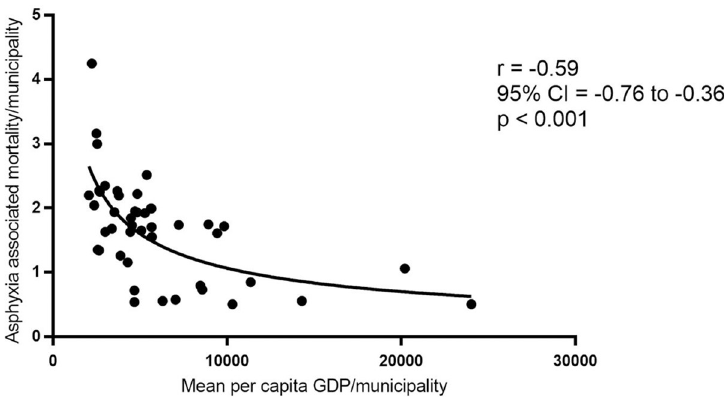
Fig 5. Dispersion of mean per capita GDP rates and asphyxia-associated mortality rates per municipality. Data presented for 45 municipalities with significant G in LISA significance map with lognormal fit curve and Spearman correlation (r), S ã o Paulo (Brazil), from 2004 to